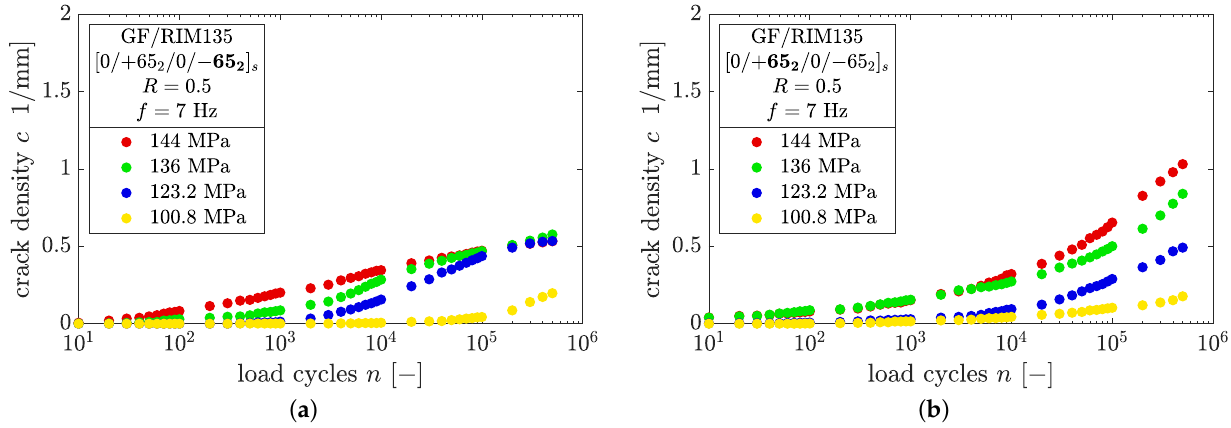
Figure A4. Results of the crack counting procedure for [ 0/ + 65 2 /0/ − 65 2 ] s -laminates for ( a ) thick and ( b ) thin layers at R = 0.5.